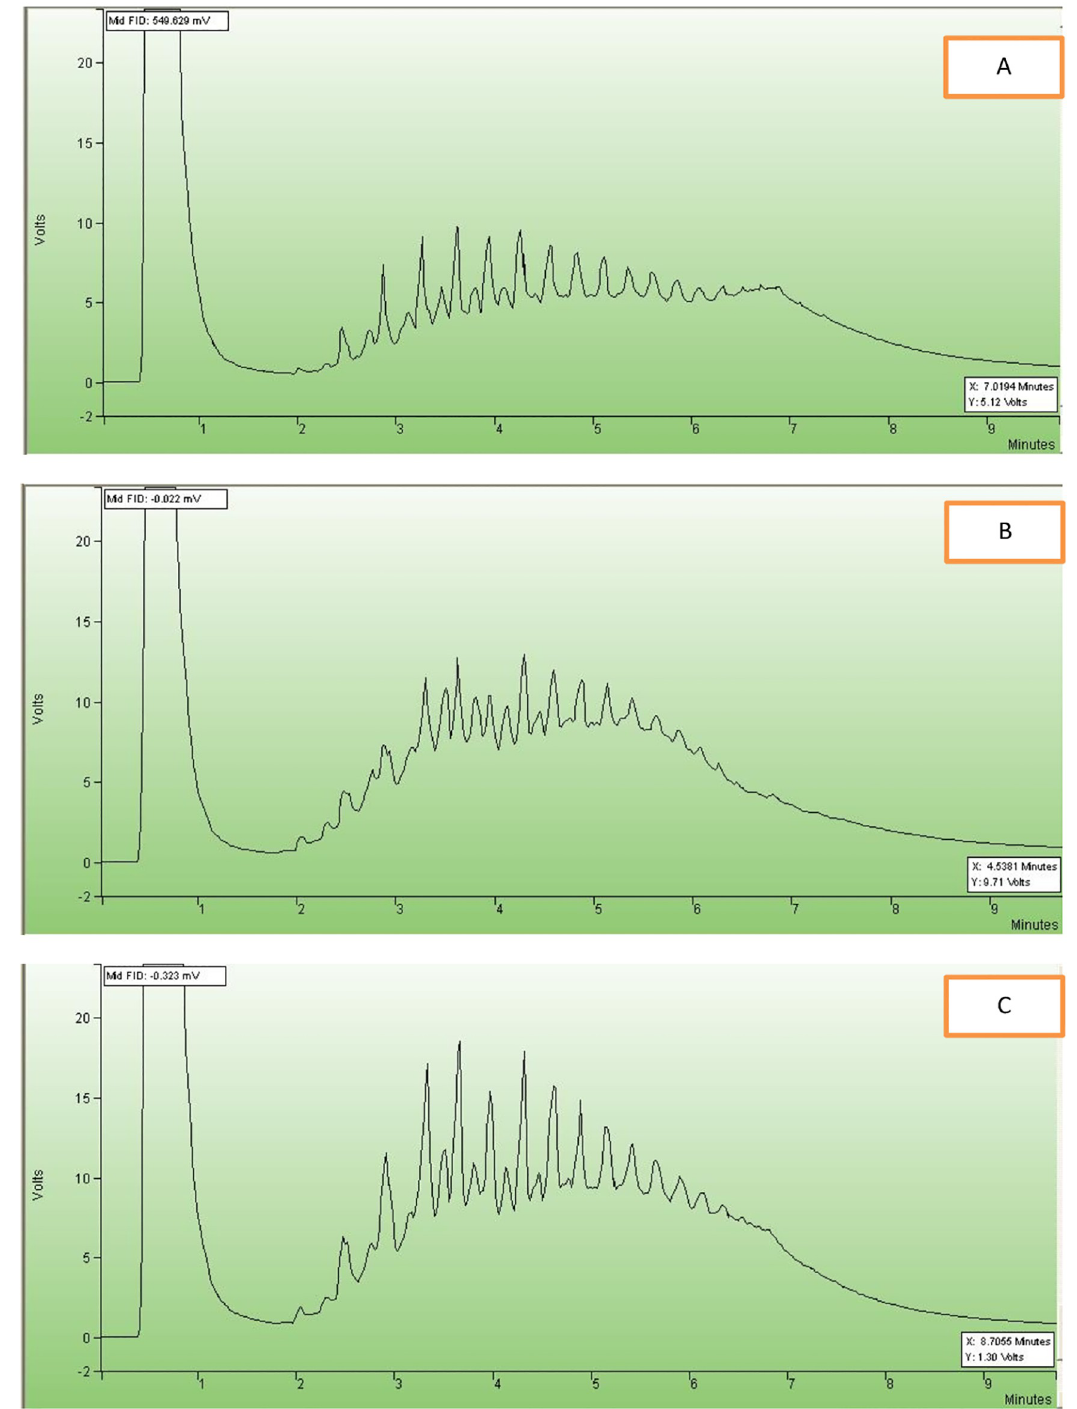
Fig 3. Compositions analysis for oil samples. (A) untreated oil, (B) treated crude oil by Rhodococcus erythropolis IGTS8, and (C) Thiobacillus